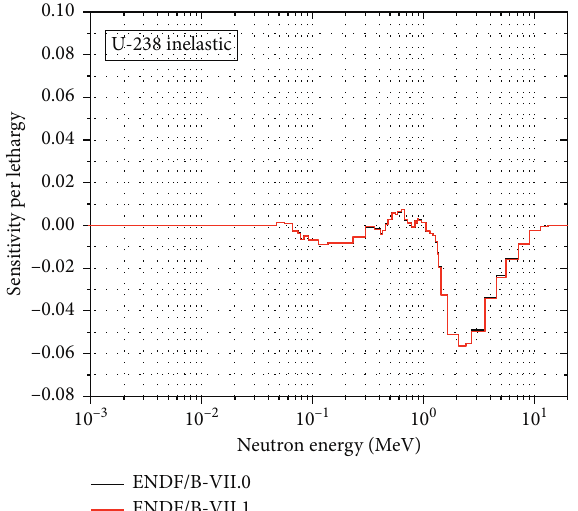
Figure 19: Energy-dependent sensitivities of k